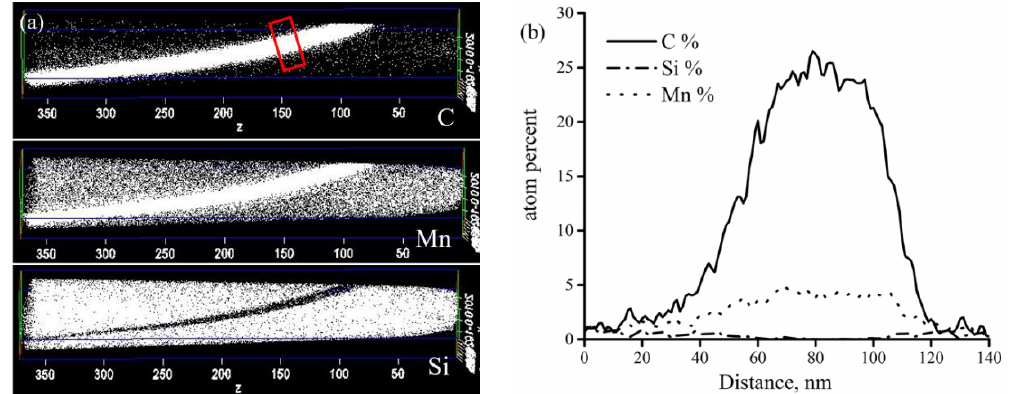
Figure 14. The 3D element maps of an APT needle taken in the WEL and close to the WEL/pearlite boundary ( a ) and the composition profiles of volumes enclosed in the hollow rectangle ( b ).